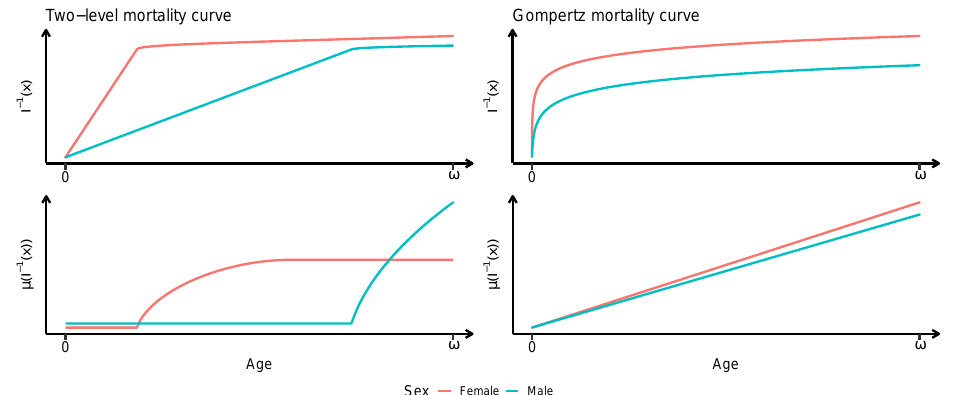
Figure 2. Illustration of I − 1 ( x ) and µ ( I − 1 ( x )) for the two-level mortality curve depicted in Figure 3 ( left panels) and a Gompertz mortality curve ( right panels).